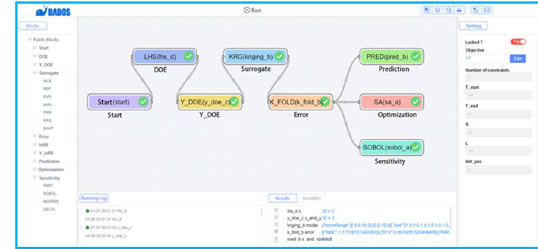
Figure 7 The parameter configuration pane of the LHS